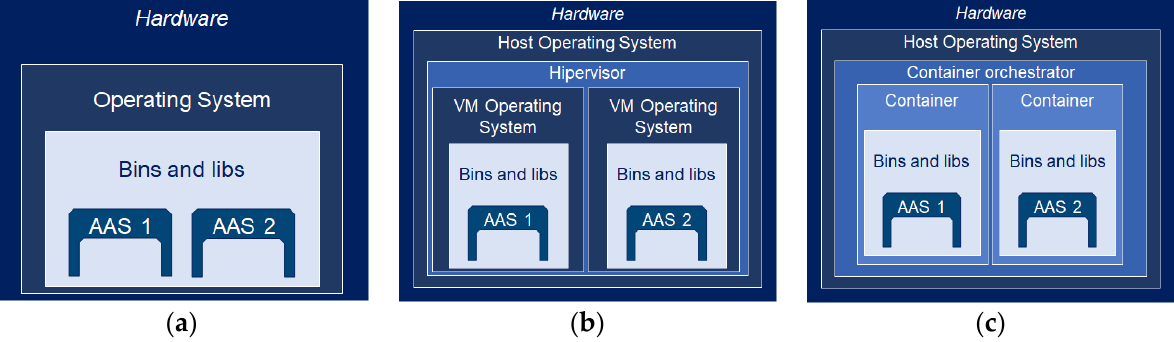
Figure 4. Virtualization perspective for implementation of the AAS: ( a ) operating system, ( b ) hypervisor, ( c ) container. Adapted from [42] with permission from the Federal Ministry for Economic Affairs and Climate Action. Scharnhorststraße 34–37, 10115 Berlin.